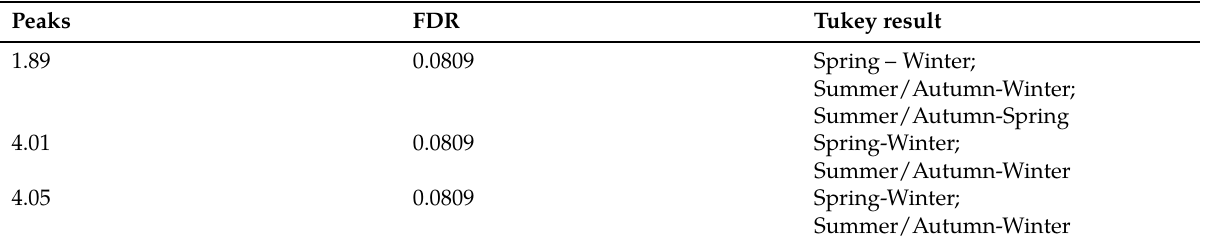
Table 2: ANOVA results for the peaks with the best corrected p -values (FDR method). Peaks